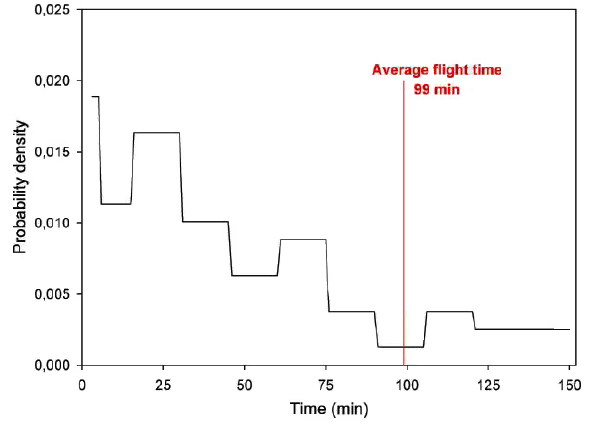
Fig. 1. Probability density function of flight duration based on Nachtigall